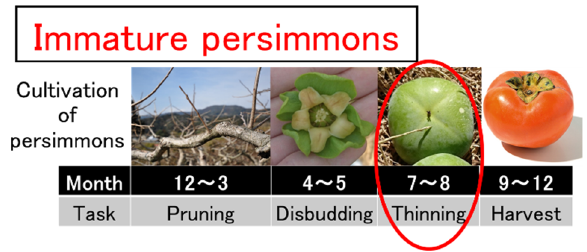
Figure 1. Cultivation of